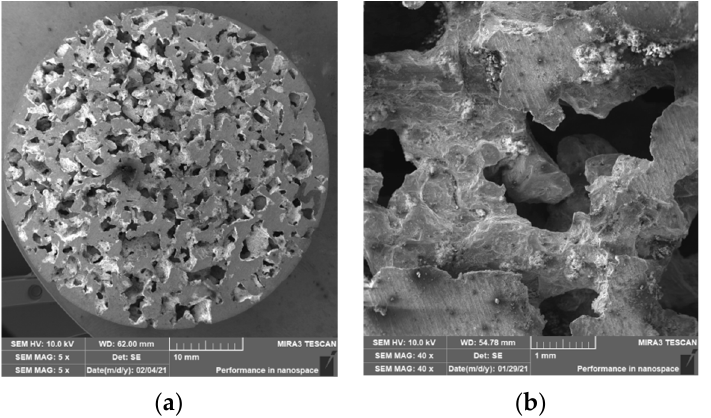
Figure 17. View of the structure of the porous material of AlSi12 alloy: ( a ) detail of the material; ( b ) scanning electron microscope image (Vega 3 Tescan, SEM HV 20.0 kV) of sample SAM6.